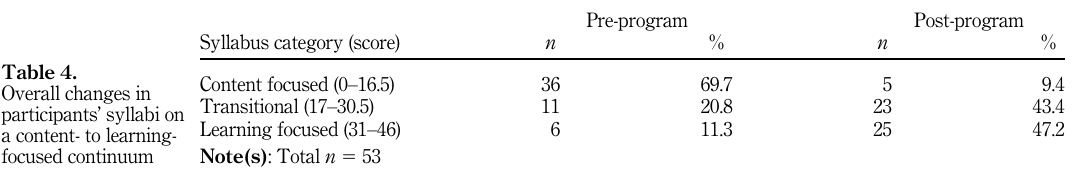
participants ’ syllabi on a content- to learning- focused